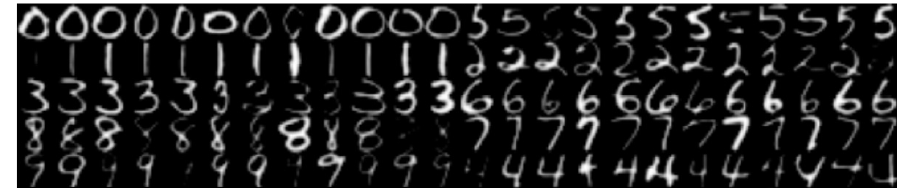
Figure 4. Sample digits images from the United States Postal Service (USPS)